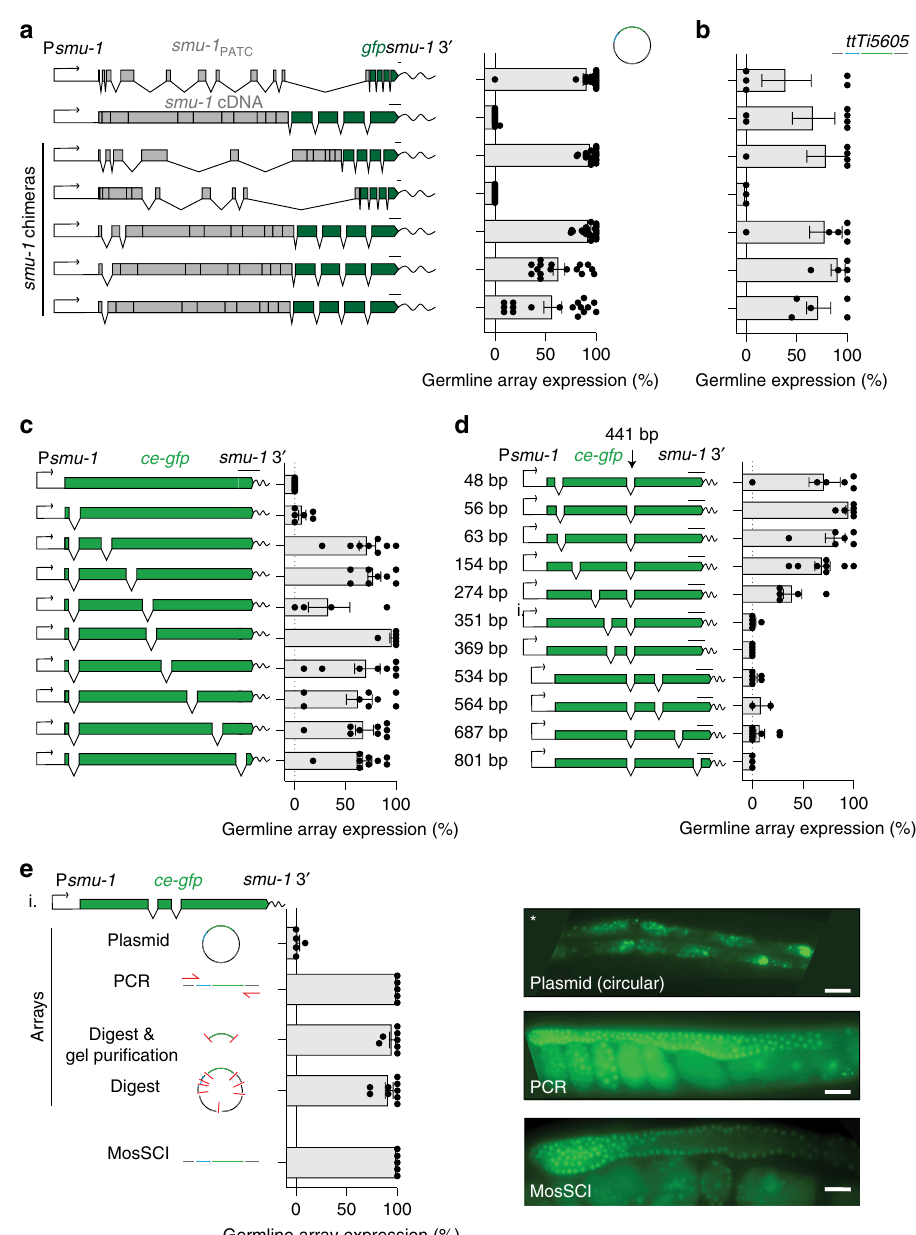
Fig. 3 The effects of splicing and the plasmid backbone on germline expression. a Germline expression of chimeric gfp -tagged smu-1 cDNA and genomic transgenes from simple arrays. n = 22, 20, 16, 27, 16, 17, and 17 biologically independent transgenic lines (from top to bottom). b Germline expression of chimeric gfp -tagged smu-1 cDNA and genomic transgenes from single-copy MosSCI insertions at the permissive ttTi5605 insertion site (Chr. II). n = 5, 6, 5, 3, 6, 5, and 5 biologically independent transgenic lines (from top to bottom). c Simple array germline expression of ce-gfp containing no synthetic introns (top), one intron, or two introns expressed from a smu-1 promoter. n = 15, 6, 8, 8, 4, 6, 8, 8, 9, and 9 biologically independent transgenic lines (from top to bottom). d Germline expression of ce-gfp containing two early or late synthetic introns expressed from a smu-1 promoter from simple arrays. n = 6, 6, 6, 8, 5, 5, 5, 6, 2, 8, and 3 biologically independent transgenic lines (from top to bottom). e The effect of transgene context on expression of ce-gfp containing two synthetic introns using the smu-1 promoter. Images (right) show typical GFP expression. n = 5, 5, 7, 9, and 5 biologically independent transgenic lines (from top to bottom). Scale bar = 20 μ m. * = non-speci fi c gut-granule fl uorescence. Conditions: plasmid = simple arrays with circular plasmid at 25 ng/ul. MosSCI = single-copy transgene insertion at ttTi5605 (Chr. II). PCR = simple arrays with PCR ampli fi ed transgene (no plasmid backbone). Digest & gel puri fi cation = KpnI, EcoRV, and ApaLI digest with the transgene coding region isolated by gel electrophoresis and gel puri fi cation (backbone removed). Digest = KpnI, EcoRV, ApaLI digest, and bulk puri fi cation over a column (backbone digested but not removed). Transgene scale bars = 100 nucleotides. All germline fl uorescence was quanti fi ed from transgenic animals imaged with a ×40 or ×63 oil objective at 25 °C. Each datapoint indicates one independent measurement of germline fl uorescence scored from 11 animals from an independent transgenic line. Bars indicate the mean, and error bars indicate the SEM. Source data are available in the Source Data fi